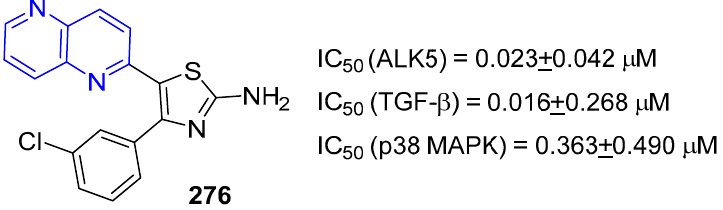
Figure 7. Inhibition of ALK5, on enzyme and TGF- α -dependent cells.